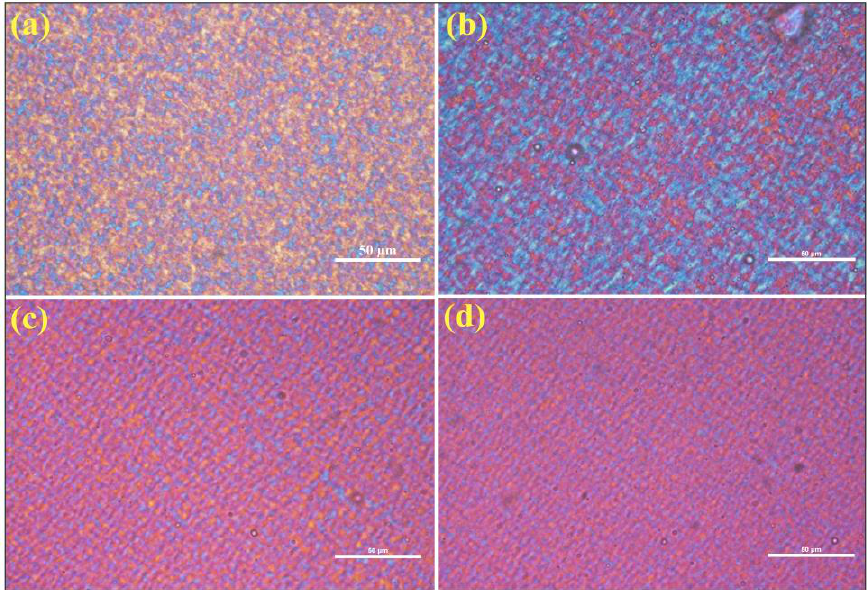
Figure 10. Polarizing microscopy (POM) microscopic images of isothermally crystallized samples